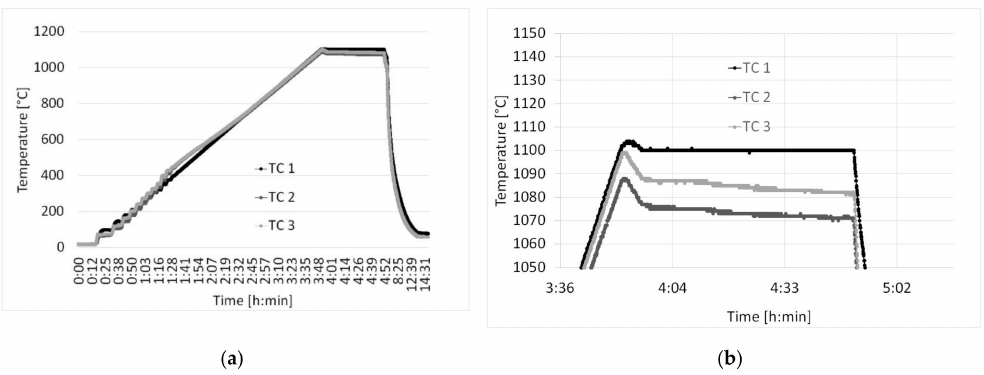
Figure 8. ( a ) Temperature profile of di ff usion bonding experiment with new TC 1 for comparison to old thermocouples. ( b ) Expanded detail at setpoint temperature of T = 1100 ◦